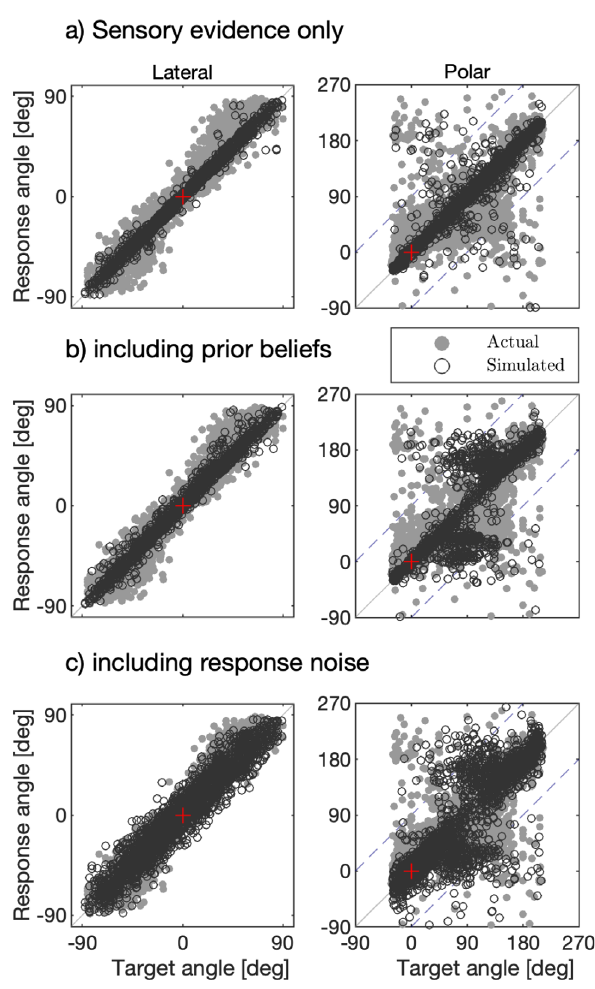
Figure 6. Effects of likelihood, prior, and response noise on predicted response patterns as a result of modeling the directional localization of broadband noise bursts. (a) Likelihood obtained by sensory evidence (i.e., no spatial prior and no response noise). (b) Bayesian inference (with the spatial prior but no response noise). (c) Full model (with prior and response noise). Gray: actual data of NH16 from [23]. Black: estimation obtained by the model considering spectral gradient pro fi les (GPs). Red cross: frontal position. Blue dashed lines separate regions of front-back